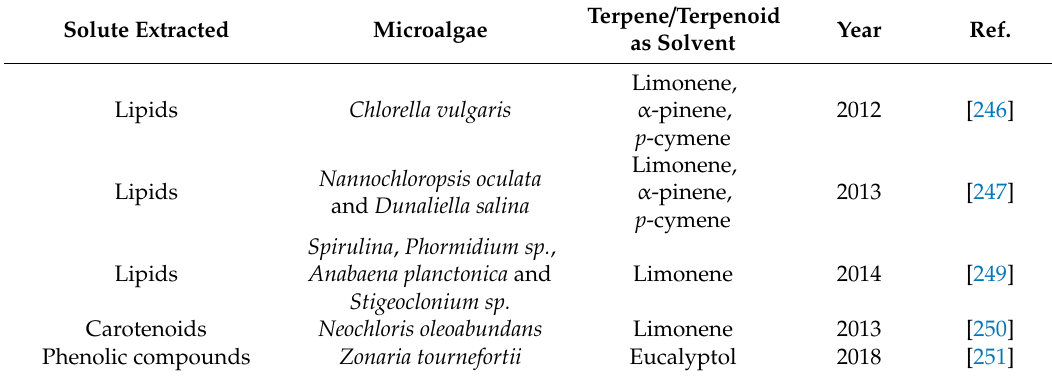
Terpene / Terpenoid Year Ref. as Solvent